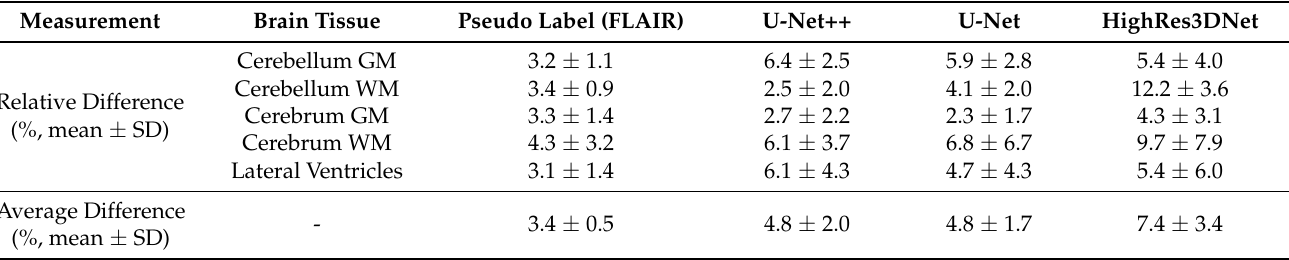
Table 3. Relative difference between the FreeSurfer labels (T1w) and in the pseudo-labels, U-Net++, U-Net, and High- Res3DNet. GM, gray matter; SD, standard deviation; WM, white